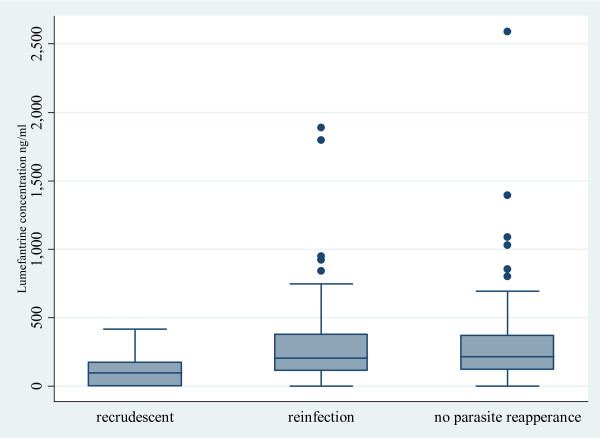
Box plots of day 7 lumefantrine concentrations versus endpoints after treatment with artemether-lumefantrine